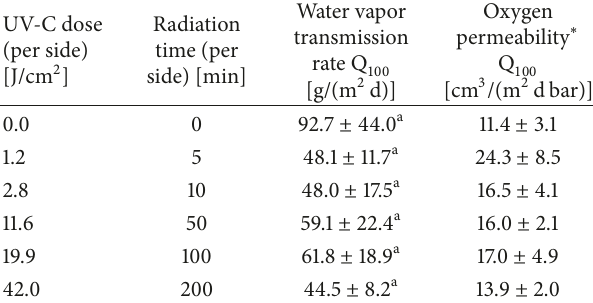
Table 3: Water vapor transmission rate and oxygen permeability normalized to 100 𝜇 m film thickness as a function of the UV dose. Different letters indicate significant differences (𝑝 < 0.05)